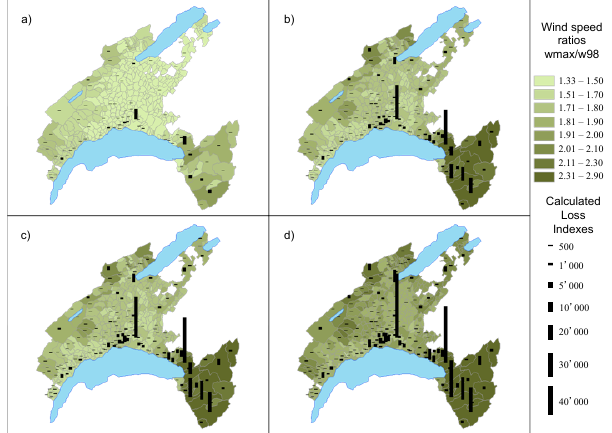
Fig. 5. Loss index calculations, with the corresponding normalised wind speeds for (a) Storm 4, (b) Storm Lothar, (c) Storm Lothar with populations projected for the year 2030 and (d) Storm Lothar with 10% enhanced wind